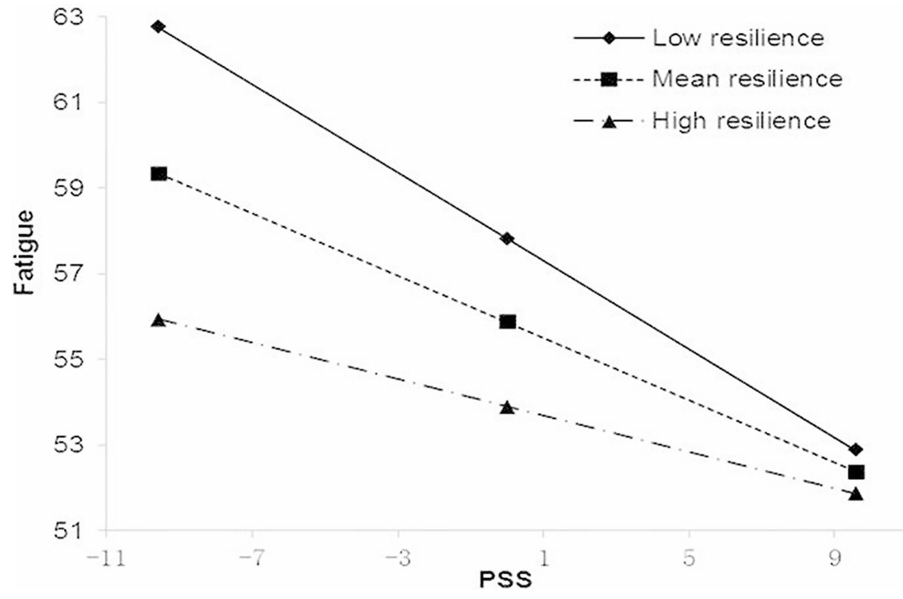
Fig 1. Moderating effect of resilience on PSS-fatigue association.